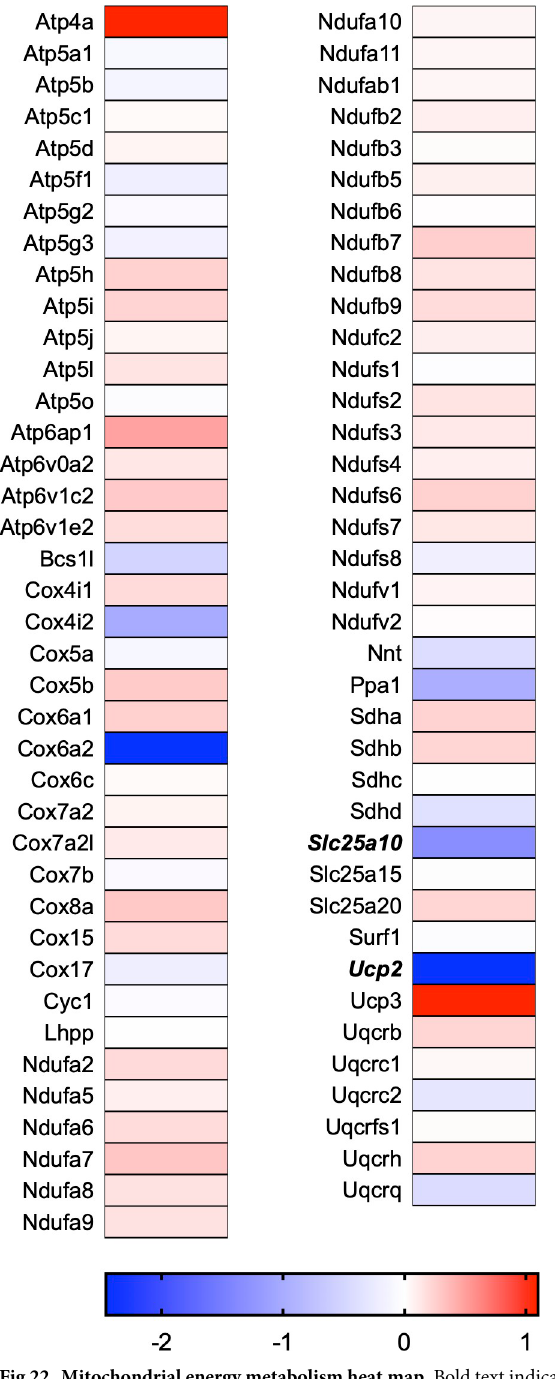
Fig 22. Mitochondrial energy metabolism heat map. Bold text indicates significantly altered gene